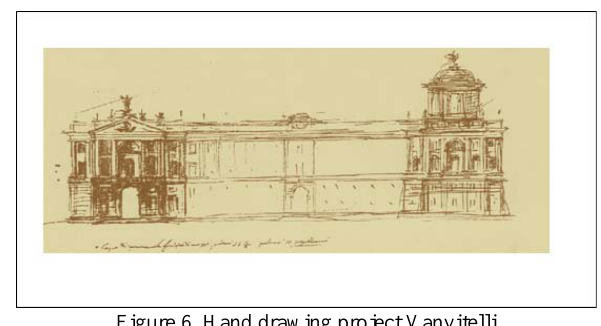
Figure 6. Hand drawing project